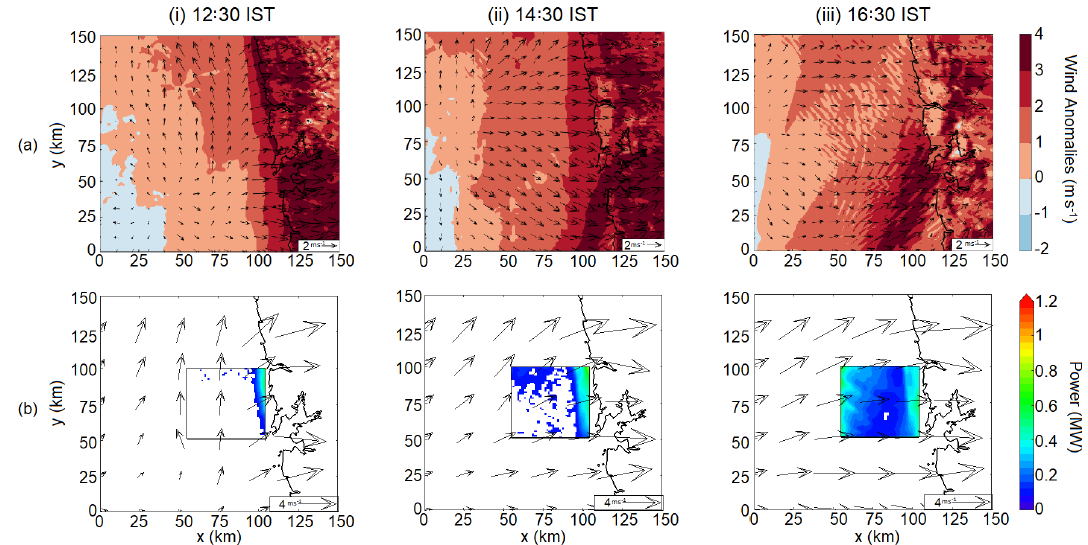
Figure 5. (a) Wind anomalies and (b) power production for 4 May 2018 at (i) 12:30IST, (ii) 14:30IST, and (iii) 16:30IST.